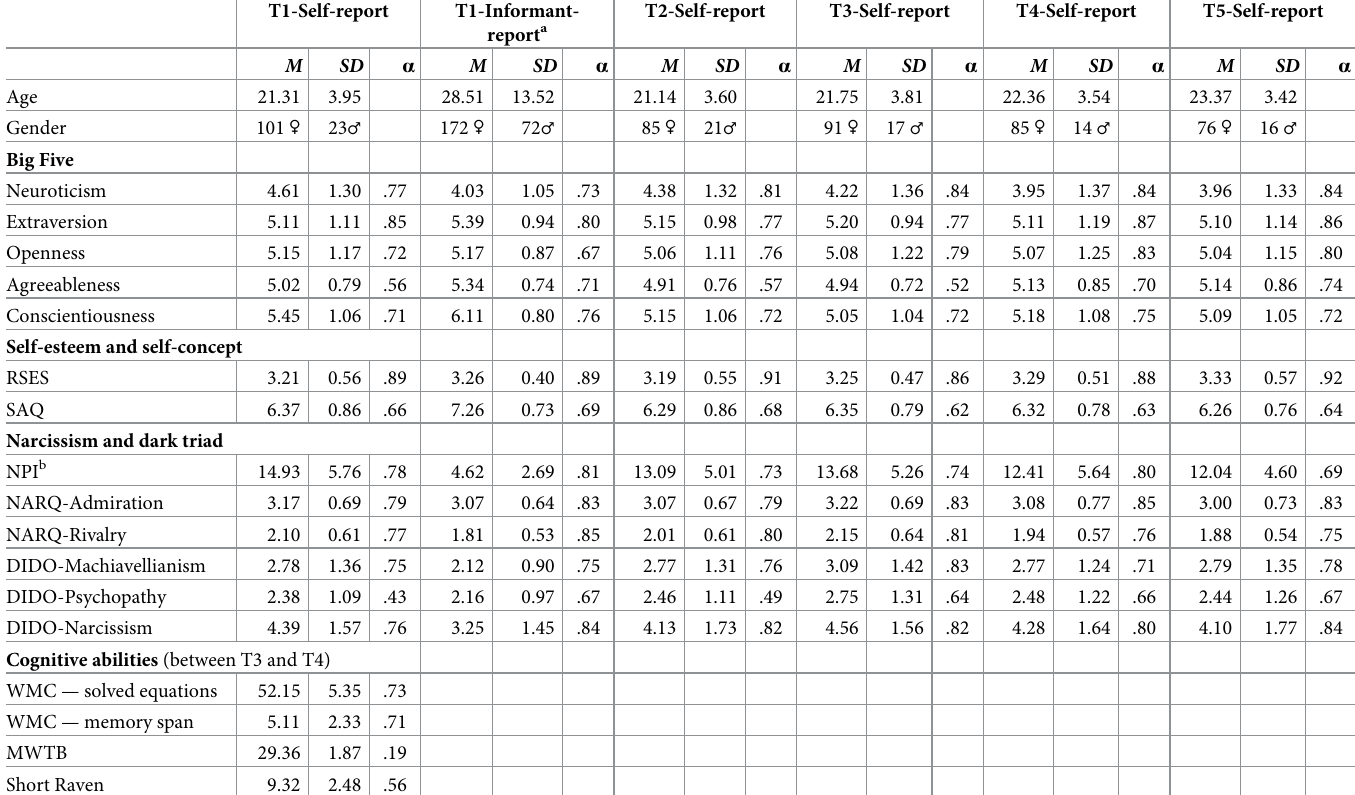
Table 13. CONNECT selected traits and cognitive abilities.